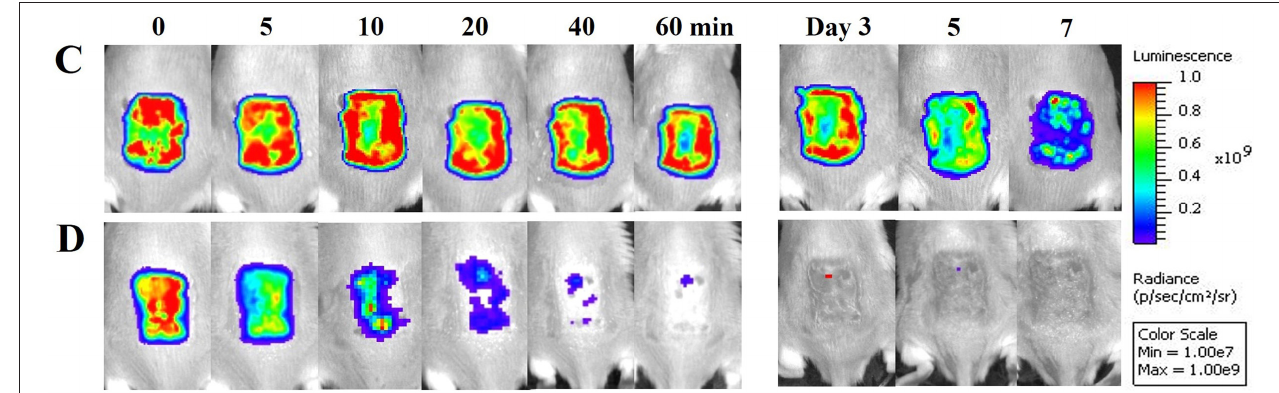
FIGURE 4 | Oregano oil treatment of PA01 infections in the burn wounds. (A,B) Gram-stained longitudinal section (A) and crossing section (B) of a representative wound showing the presence of PA01 biofilms outlined in red. The skin sample was harvested 24h after bacterial inoculation. (C,D) Successive bacterial luminescence images of representative wounds infected with 5 × 10 6 CFU of luminescent PA01 with (D) and without (C) oregano oil at 10 mg/ml. The oregano oil was topically applied onto the wounds at 24h after bacterial inoculation. (E) A dose response of mean bacterial luminescence of the wounds infected with 5 × 10 6 CFU of PA01 in the presence or absence of oregano oil treatment at 5 or 10 mg/ml. (F) Time courses of mean bacterial luminescence of the infected wounds in the presence or absence of oregano oil treatment at 5 or 10 mg/ml from days 2 to 7. (G) Mean areas under the bacterial luminescence curves (F) , representing the overall bacterial burden of infected wounds. (H) . The wounds were treated with grape seed oil (control) or oregano oil 24 h after infection and bacterial CFU were quantified on day 7 after bacterial inoculation. RLU, relative luminescence units; A.U., arbitrary units. The data represent means ± SDs ( n = 8). ** p < 0.01, ### or *** p < 0.001 and #### or **** p < 0.0001 in the presence vs. absence of oregano oil. ns, no significance.